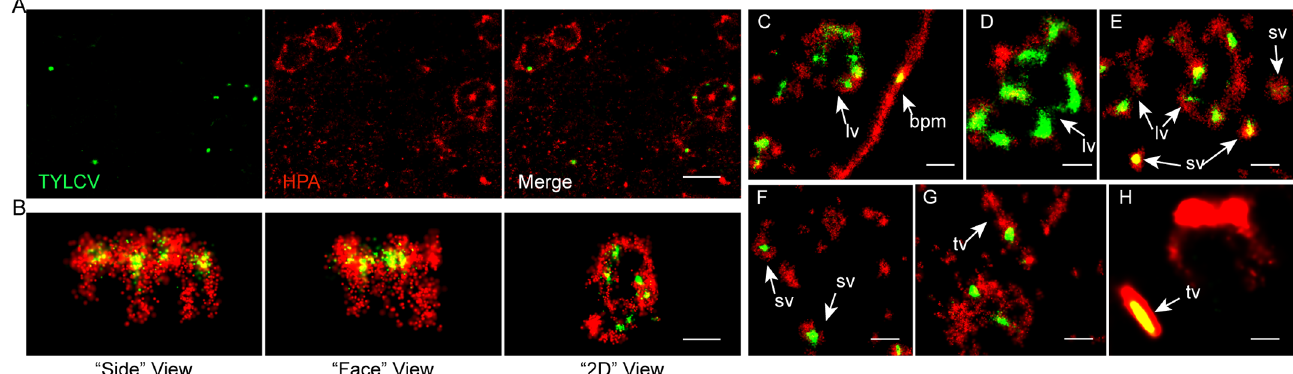
Fig 9. Super-resolution imaging of HPA-labeled vesicles and TYLCV in midgut. Midguts of whiteflies exposed to TYLCV-infected tomato plants for a 3 d AAP were dissected and prepared for super-resolution imaging. (A) STORM images of HPA-labeled vesicles and TYLCV. Lectin HPA formed membrane-like structures and encapsulated TYLCV viral particles in it. Scale bar, 2 μm. (B) 3D STORM image of an HPA-labeled vesicle, allowing the visualization of the vesicle from different angles. The “side” views are from the X axis and the “face” views are from the Y axis. Scale bar, 0.5 μm. (C) Viral particles that have reached the basal plasma membrane ( bpm ) of epithelial cells. Scale bar, 0.5 μm. (D-F) HPA-labeled vesicles with sizes from 200 nm to 2 μm are visible. TYLCV virions can be detected in large vesicles ( lv ) with high pleomorphism and small vesicles ( sv ) that are always spherical. Scale bar, 0.5 μ m. (G-H) Tubular vesicles ( tv )containing TYLCV. Scale bar, 0.5 μ